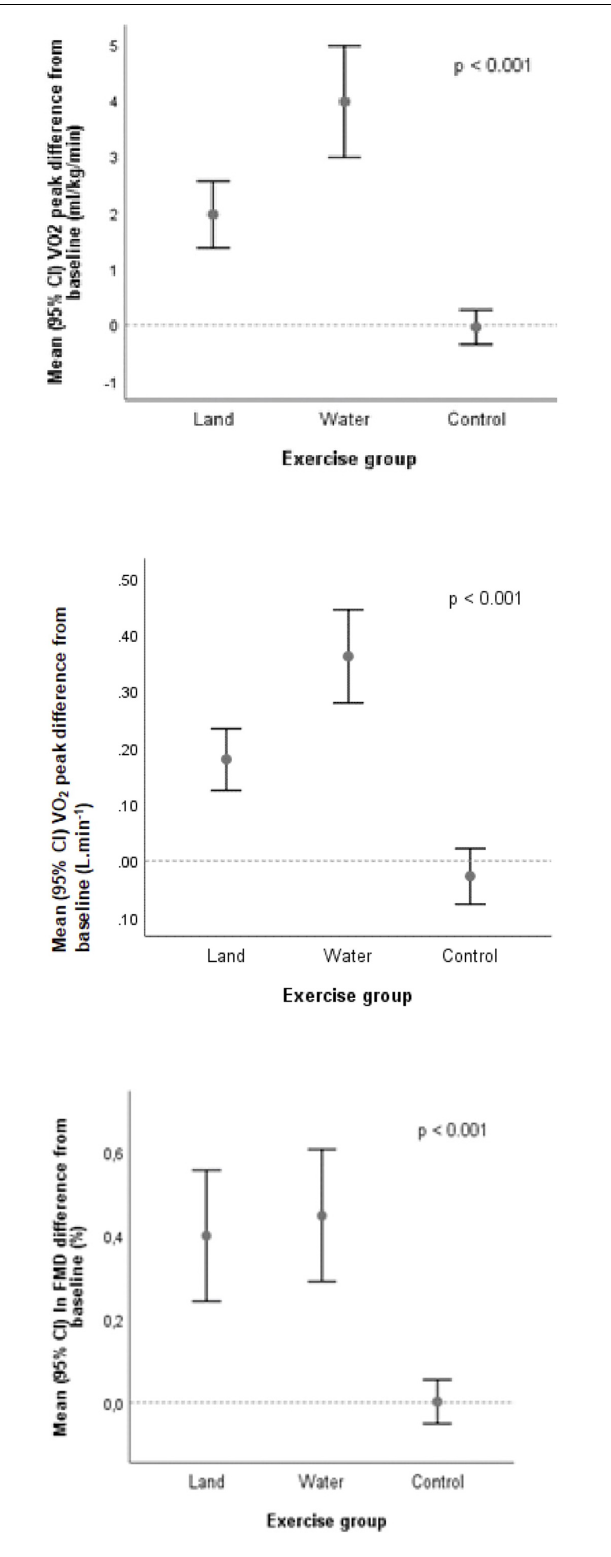
FIGURE 2 | Changes in aerobic exercise capacity (˙VO 2 peak) and flow- mediated dilatation (FMD) expressed on the logarithmic